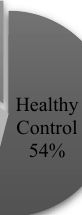
Figure 3. Distribution of the population by clinical condition (healthy/pathological).